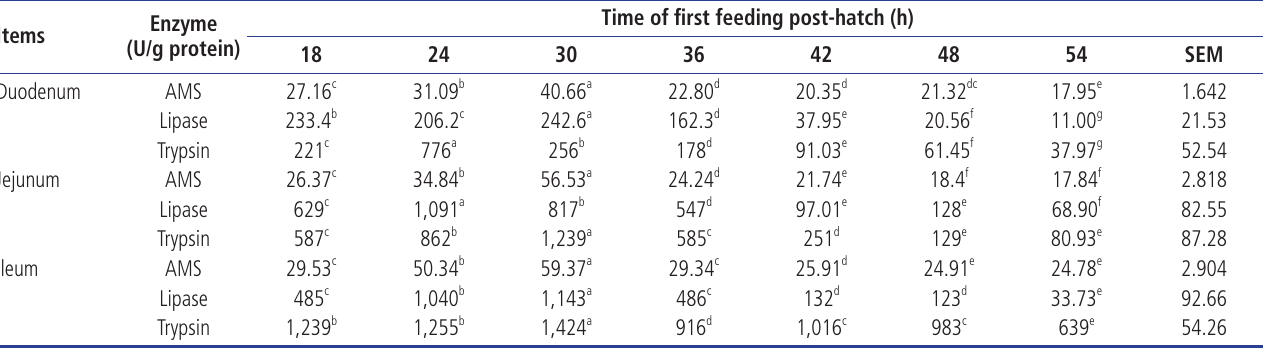
Time of first feeding post-hatch (h)